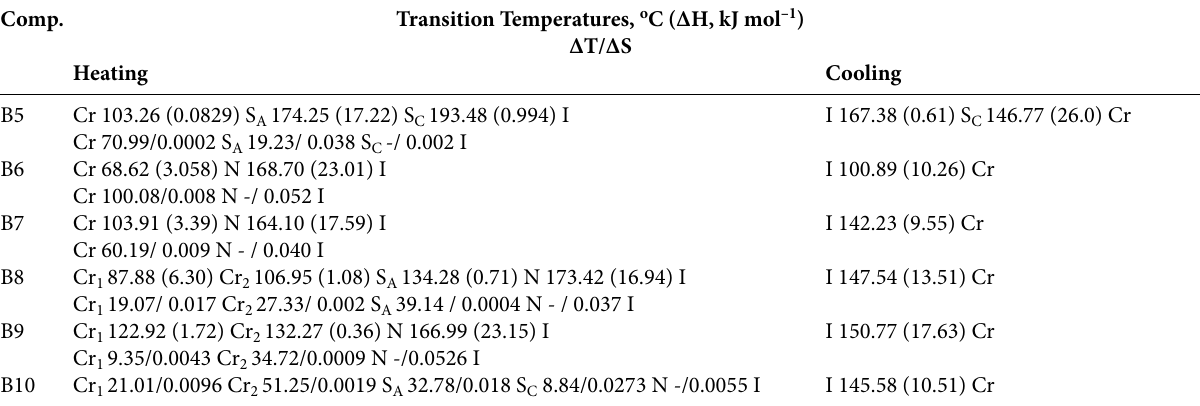
Table 1 . Phase transitions and transition enthalpy for chalcone esters B5 – B10 under heating and cooling cycle Comp.